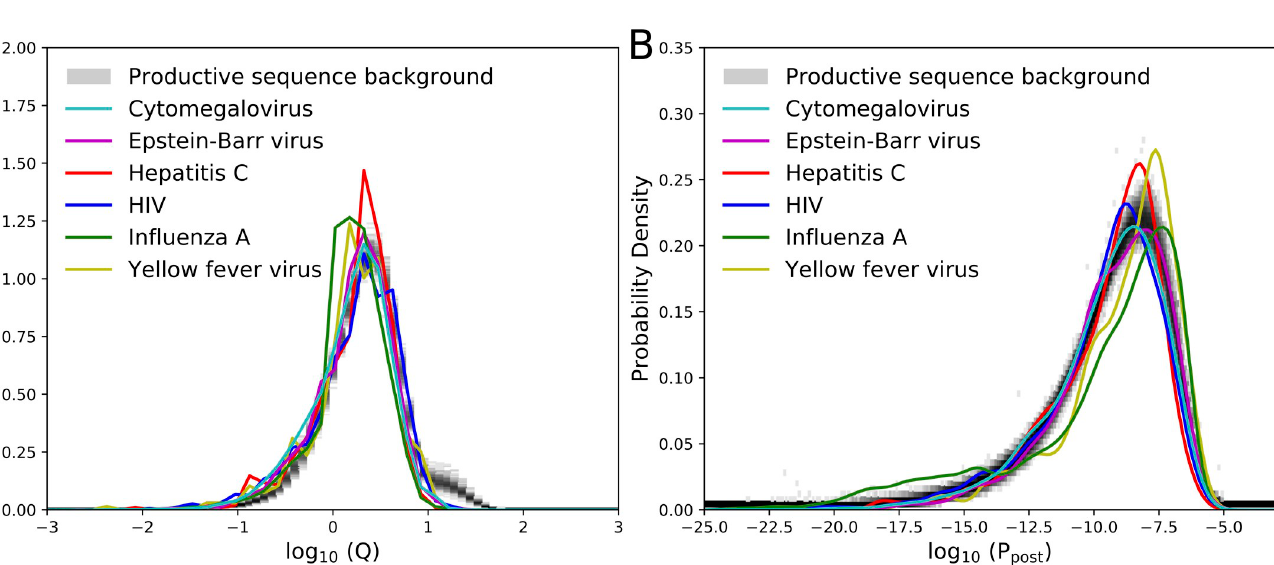
are ‘universal’ models learned from sequences post